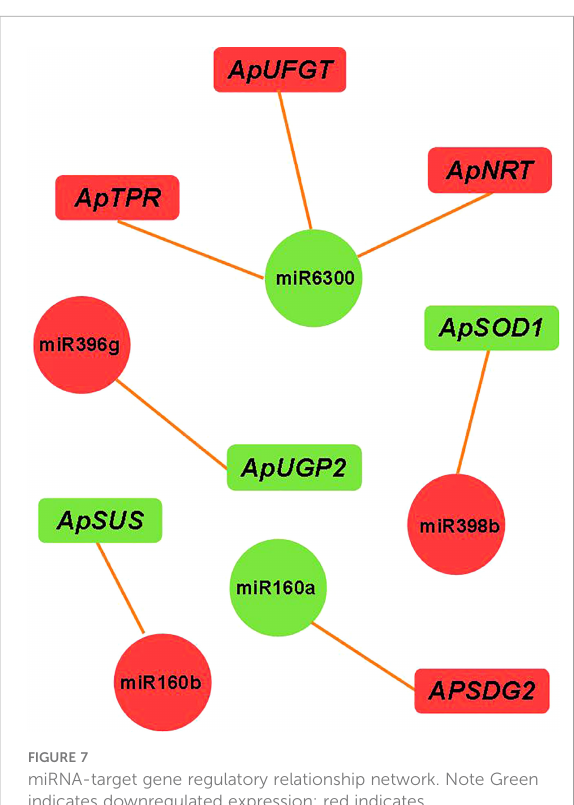
FIGURE 7 miRNA-target gene regulatory relationship network. Note Green indicates downregulated expression; red indicates upregulated